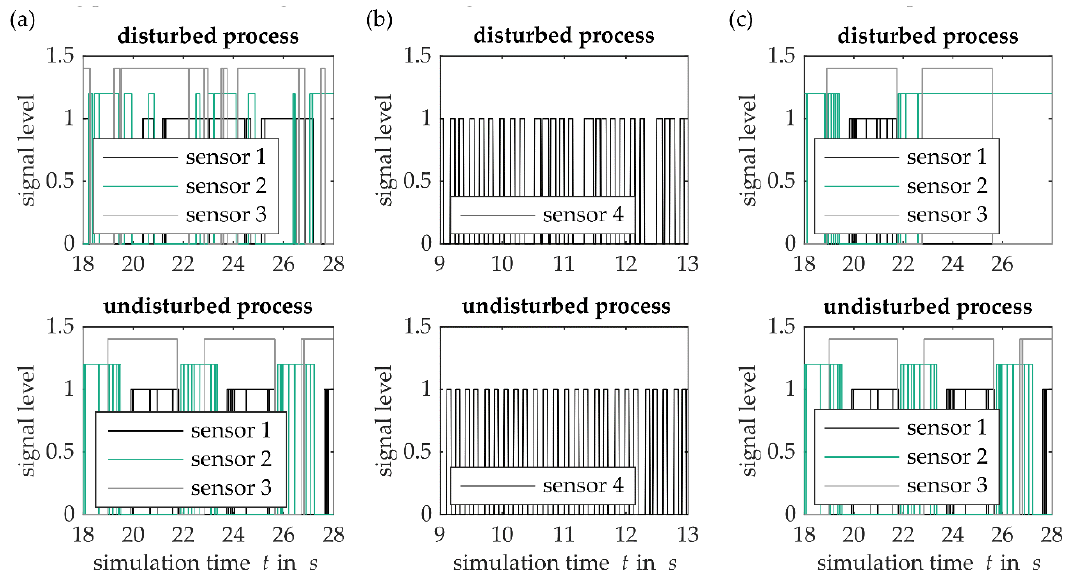
Figure 9. ( a ) Switching characteristics simulating overly-high products (class 1); ( b ) switching characteristics simulating an edge between conveyor belts (class 2); ( c ) switching characteristics simulating a contaminated sensor (class 4).